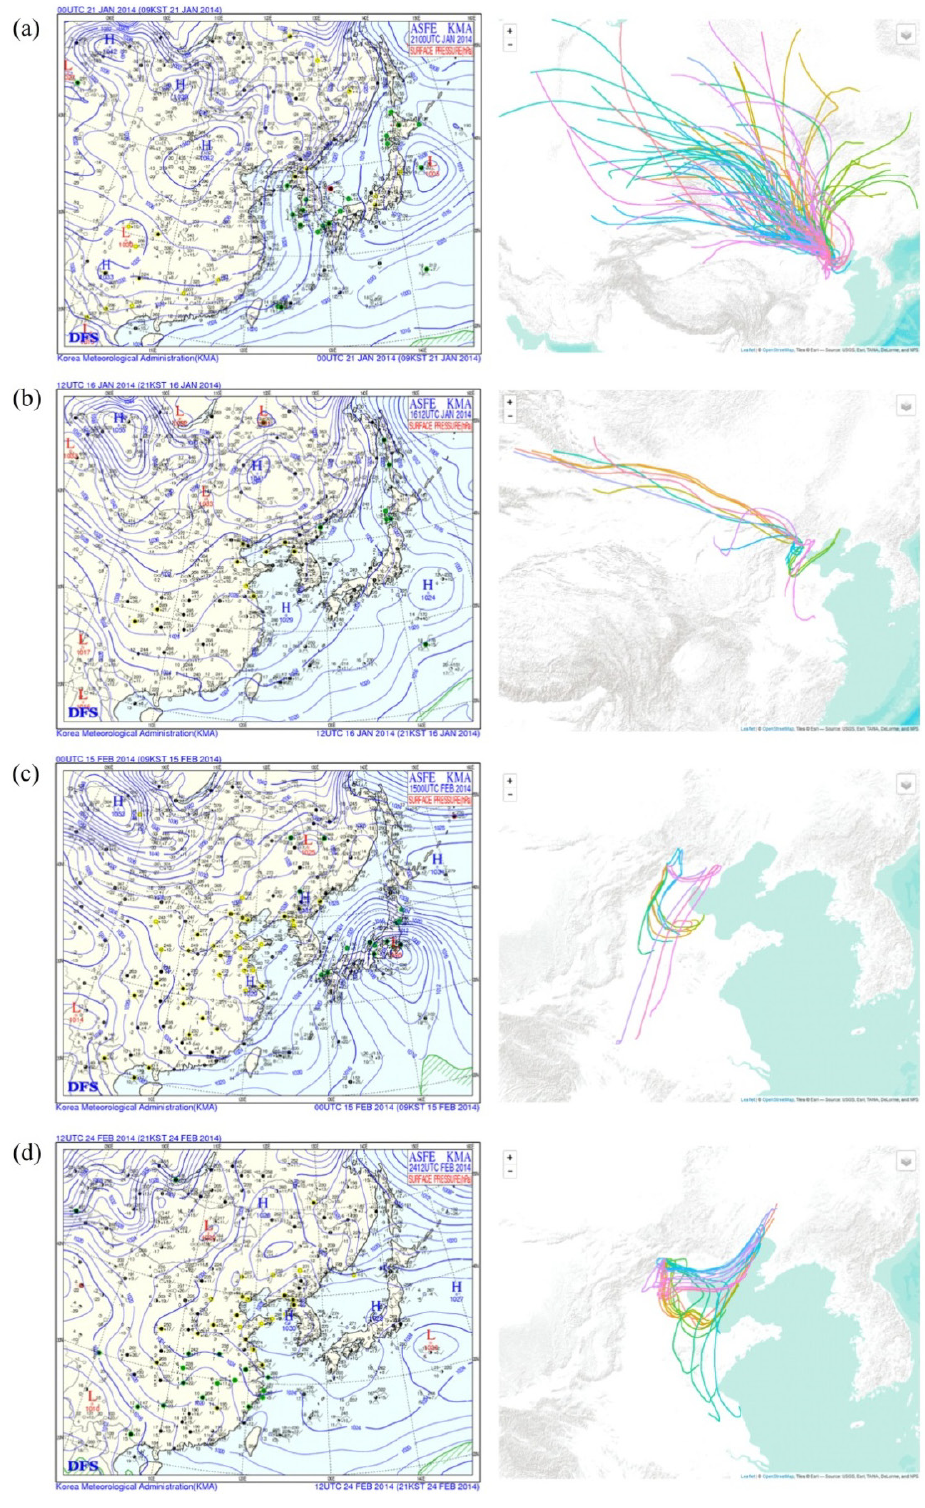
Figure 4. Surface weather maps and 72h backward trajectories on days of (a) non-haze (57 days), (b) no/blue-alert haze (4 days), (c) orange- alert haze (3 days), and (d) red-alert haze (6 days). Trajectories were calculated twice a day at 18:00 and 06:00UTC for non-haze days in (a) and every 6h at 12:00, 18:00, 24:00, and 06:00UTC for haze days in (b, c, d)